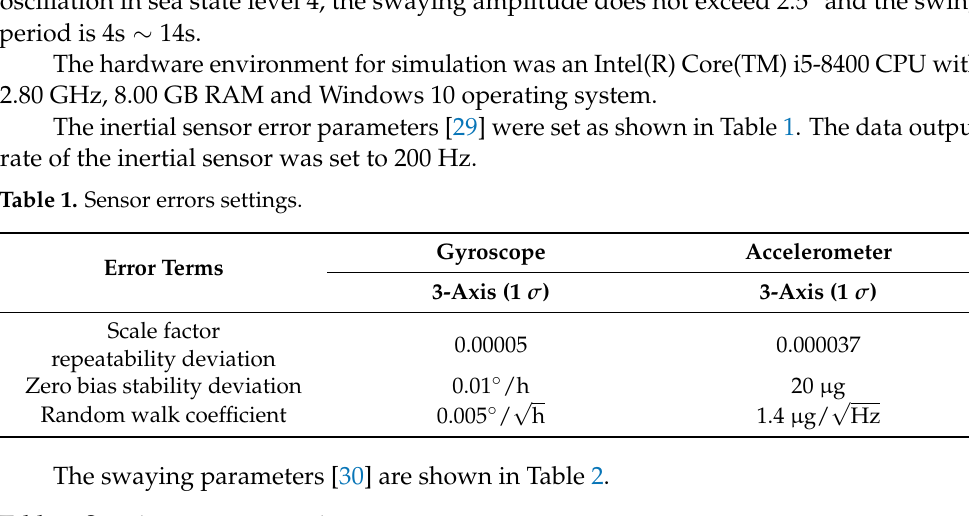
Table 2. Swaying parameter